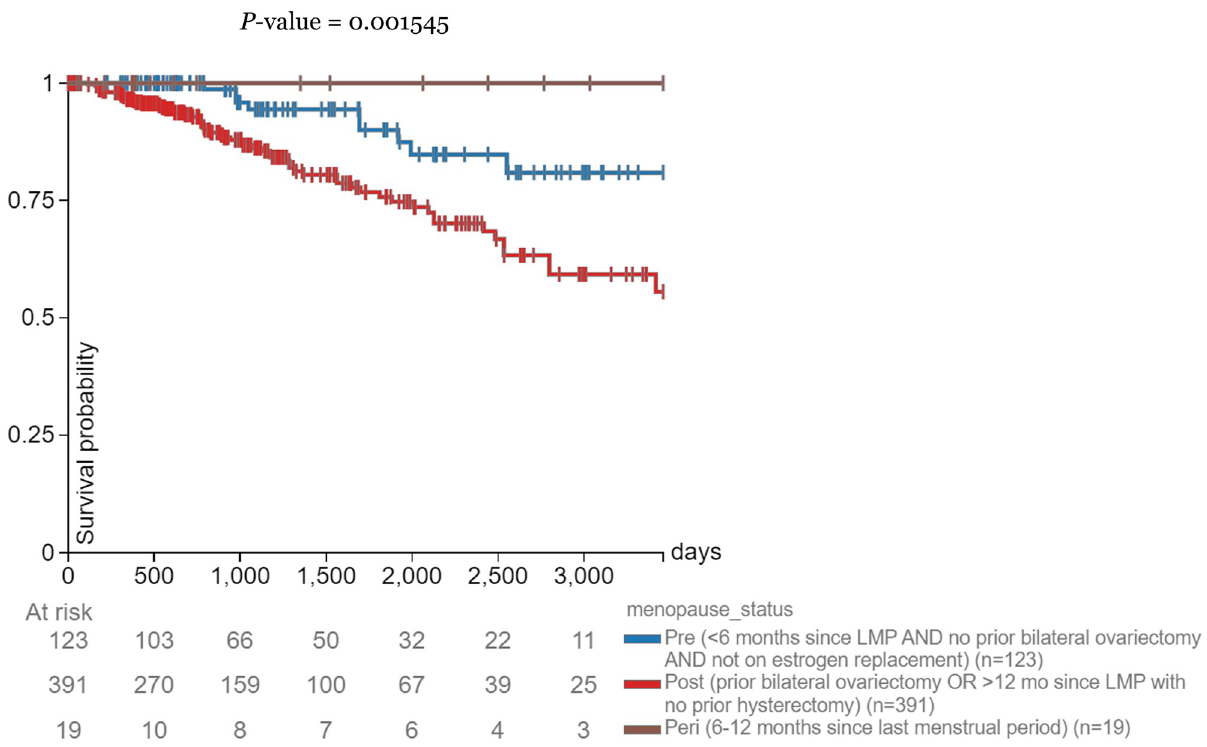
Fig 4. Days after initial treatment vs. survival probability. Correlations between days after initial treatment and survival probability in breast cancer patients with a high expression level of CPT1A ( > = 10.83 RKMP) separated by menopausal status.